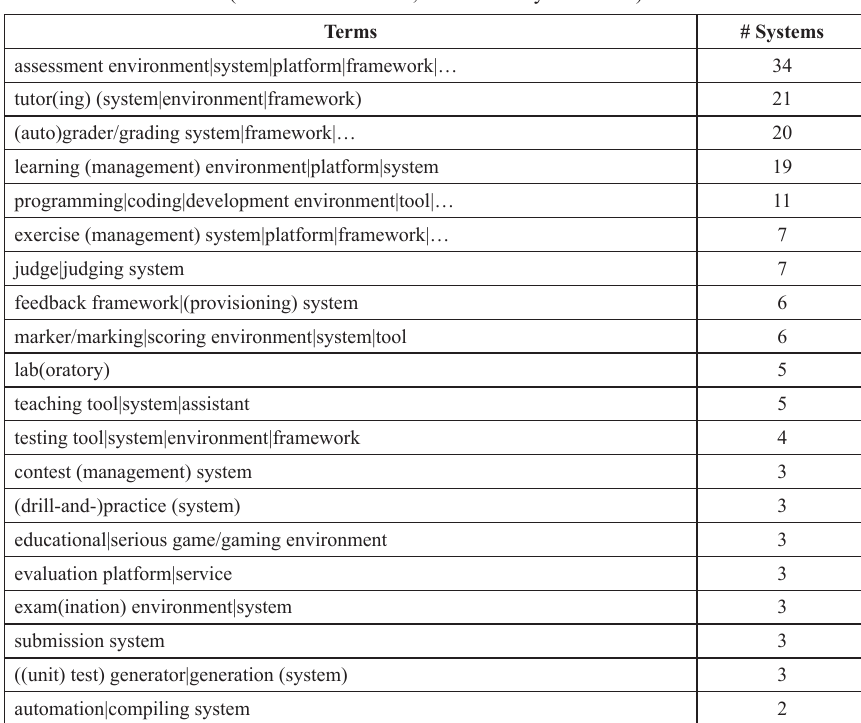
Table 4. Overview of used terms for describing the system focus (found at least twice; non-mutually